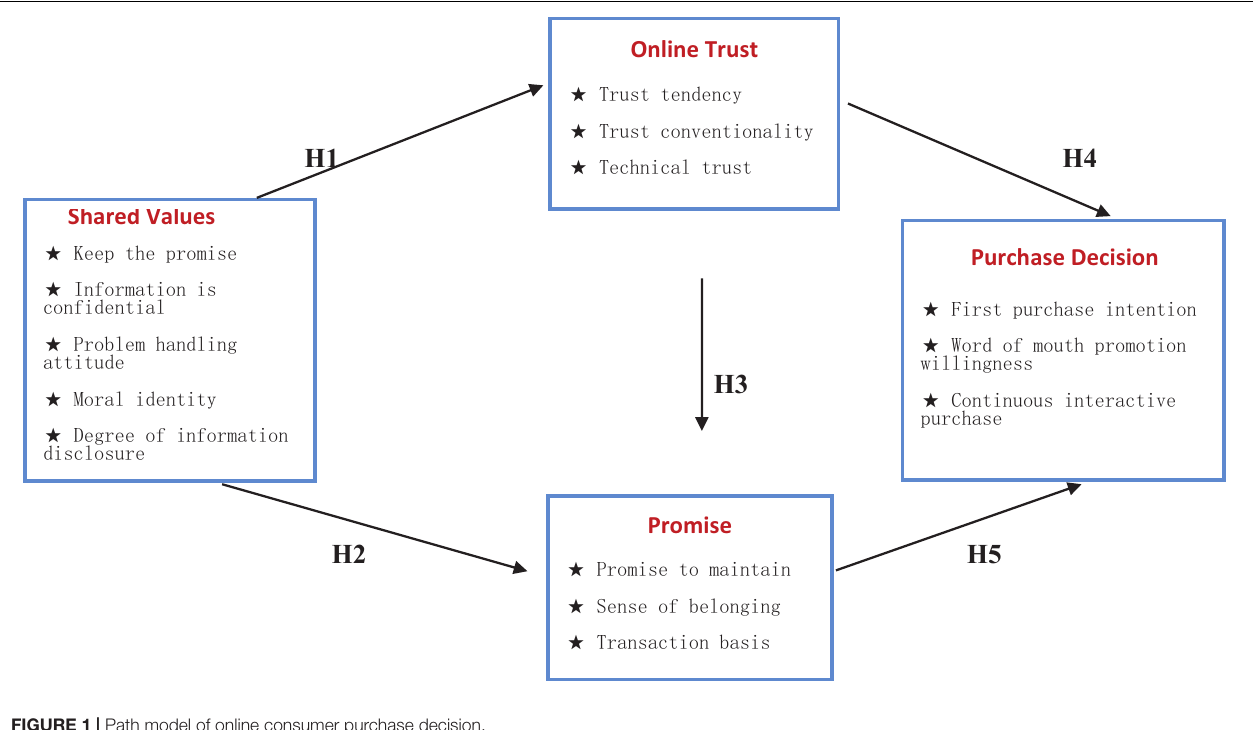
FIGURE 1 | Path model of online consumer purchase decision.